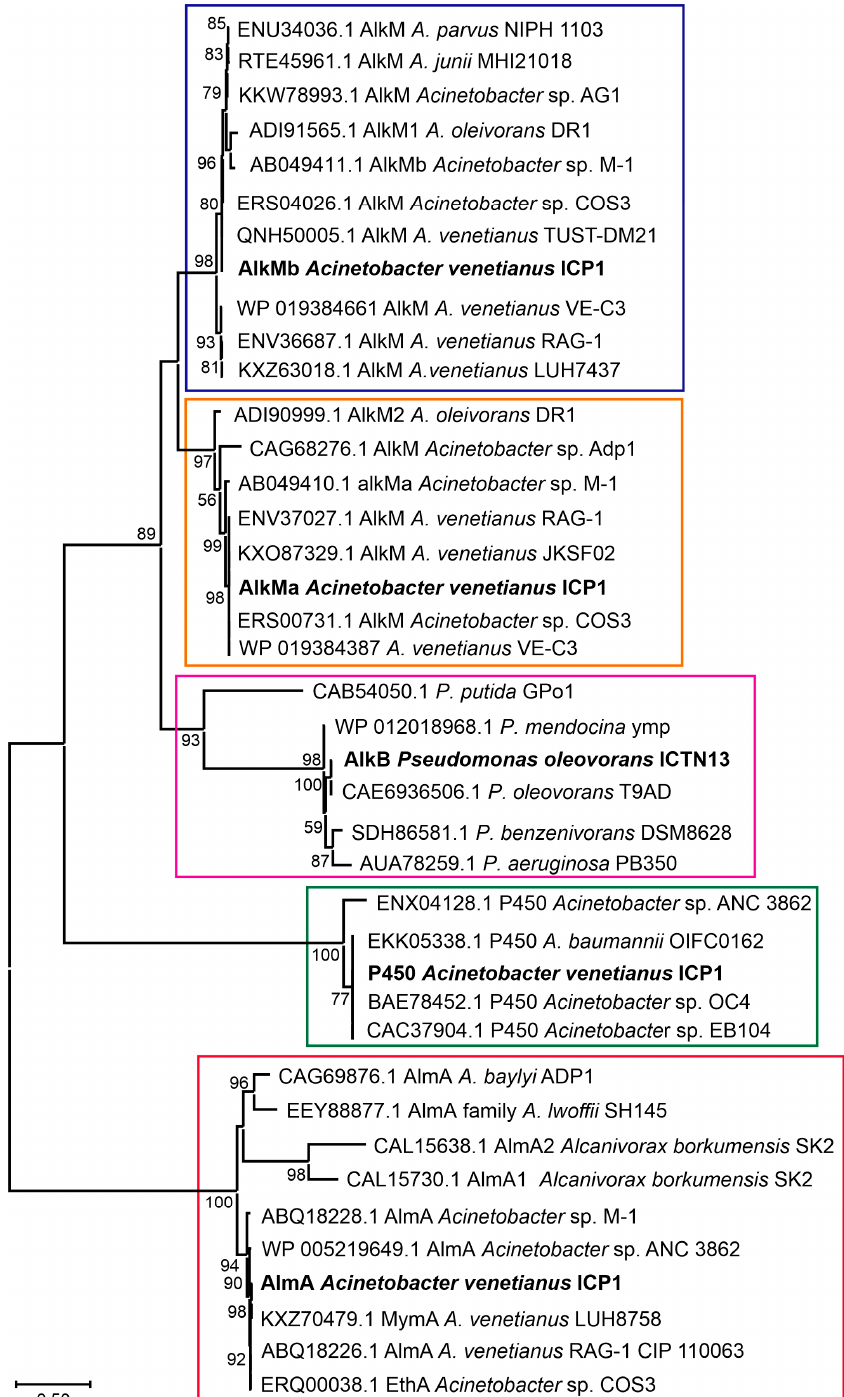
Figure 5. The phylogenetic analysis of the alkane hydroxylases using the Maximum Likelihood method and JTT matrix-based model. The alkane hydroxylases of A. venetianus ICP1 and P. oleovorans ICTN13 are labeled in bold text. Enzyme groups are separated with boxes (AlkMb—violet, AlkMa— orange, AlkB—cyan, P450—green, AlmA—red). Reference sequences obtained from GenBank are labeled with accession numbers and the strain’s name. The percentage of trees in which the associated taxa clustered together is shown next to the branches (>50%). The scale bar represents one substitution per amino acid. The analysis involved 40 amino acid sequences. There were 595 positions in total in the final dataset. Evolutionary analyses were conducted in MEGA X